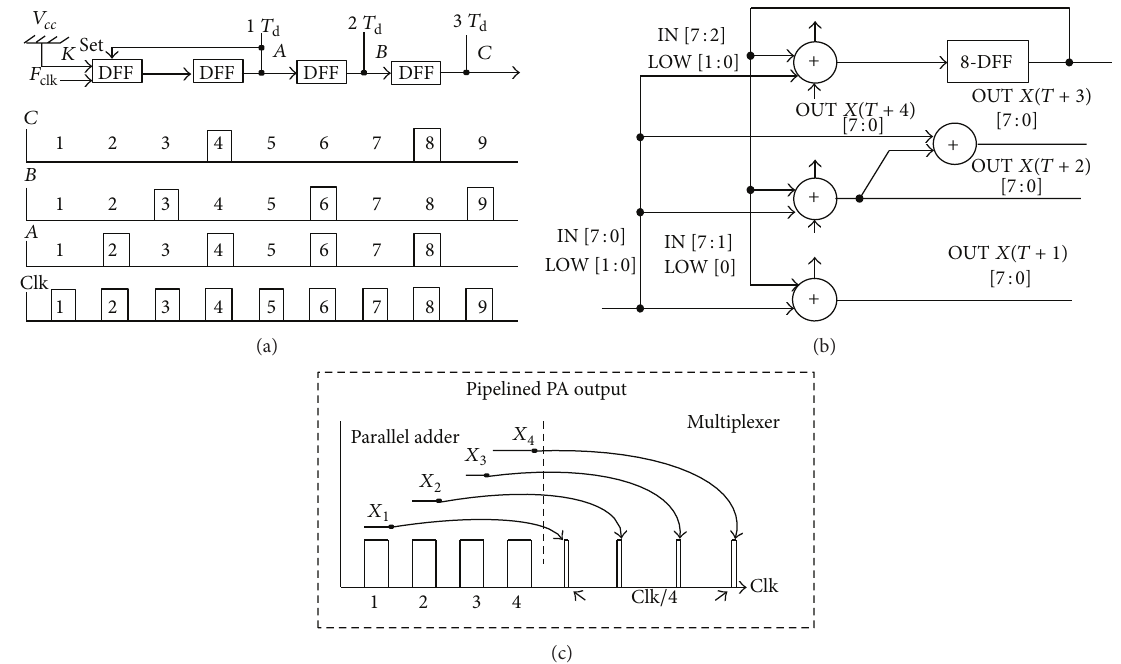
Figure 2: (a) The gated clock technique, (b) parallel adder based on progression-of-states technique, and (c) pipelined PA output.